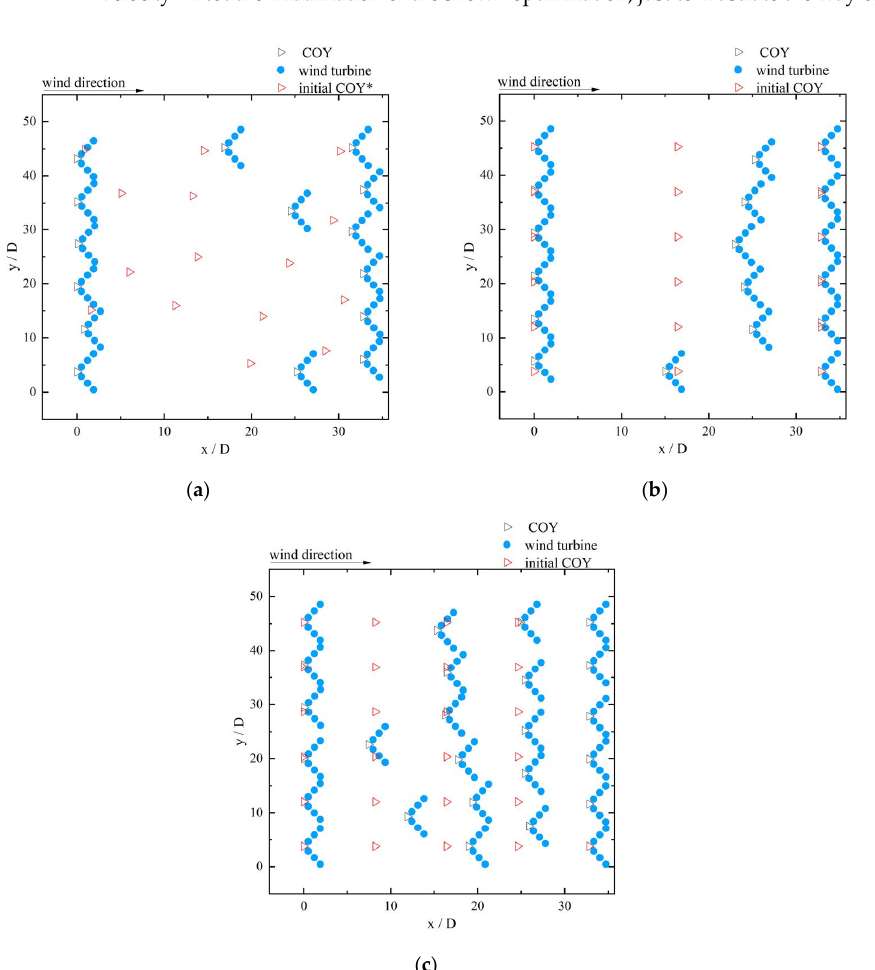
Figure 6. Optimized layout of six-turbine platforms: ( a ) 15 platforms; ( b ) 18 platforms; ( c ) 25 platforms. * Not the initialization of the shown optimization, just to illustrate the way of random